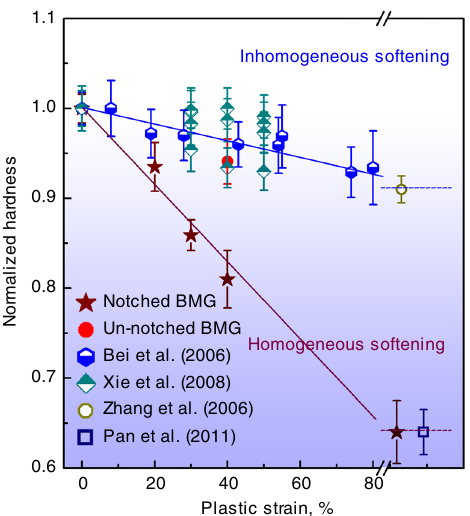
Fig. 3 Published data 4, 14, 16, 17 on the hardness values of BMGs, normalized with respect to the hardness of as-cast (undeformed) specimens.